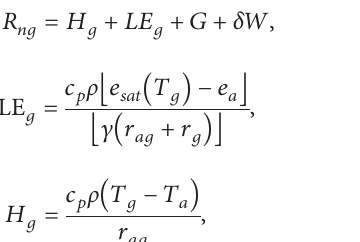
Figure 2: A schematic diagram illustrating the method for estimating upper and lower layer canopy temperatures ( T temperature ( T p ). The grey rounded rectangles denote input data, and the grey diamonds denote output